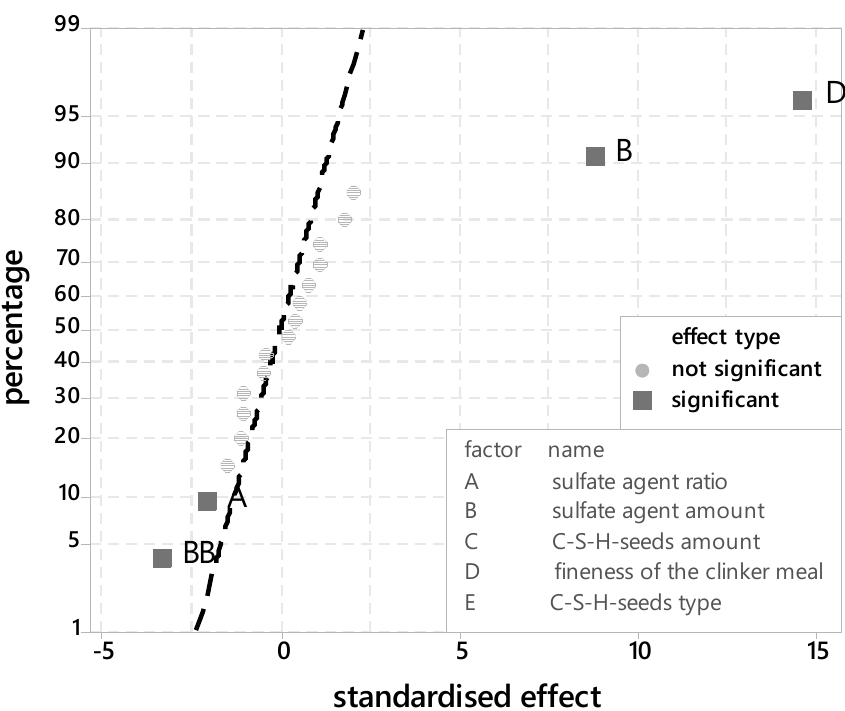
Figure 6. Probability plot for standardised effects for the aluminate phase (XRD ‐ peak 9 ‐ 9.5 °2 ϑ ).